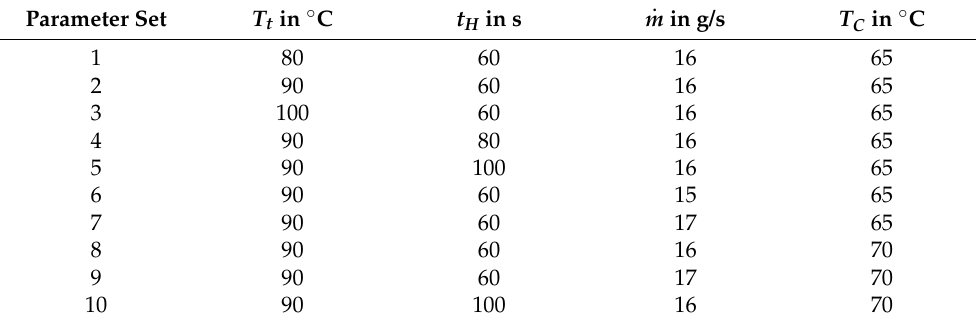
Table 1. Design of Experiments